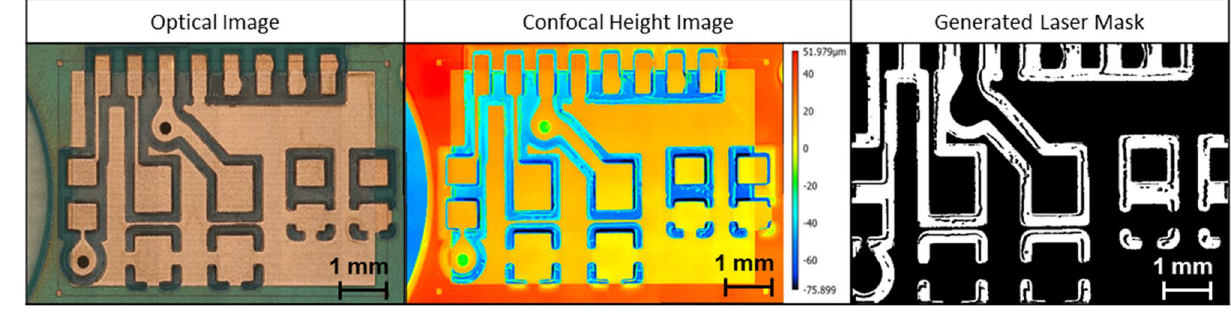
Figure 13. Generation of mask to be utilized during laser